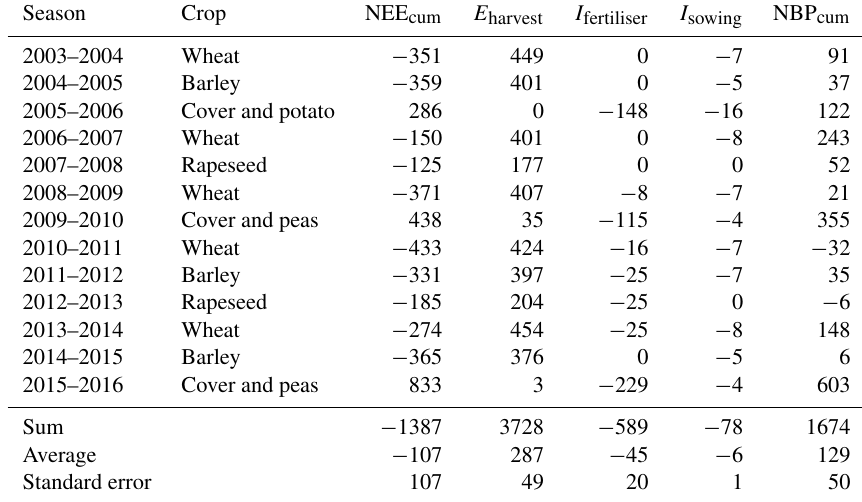
Table B2. Annual carbon budget expressed as cumulative net biome production (NBP cum ) and its contributing terms for the 13 crop years between 2003 and 2016 (units: gCm − 2 ). A crop year starts here on 16 October of one year and ends on 15 October of the next year. This date was used because the first crop was planted on 16 October 2003. NEE cum is the cumulative net ecosystem exchange, E harvest is the C export through harvest, and I fertiliser and E sowing are the C imports through organic fertilisation and sowing, respectively. The total sum, annual average and standard error of each term are also